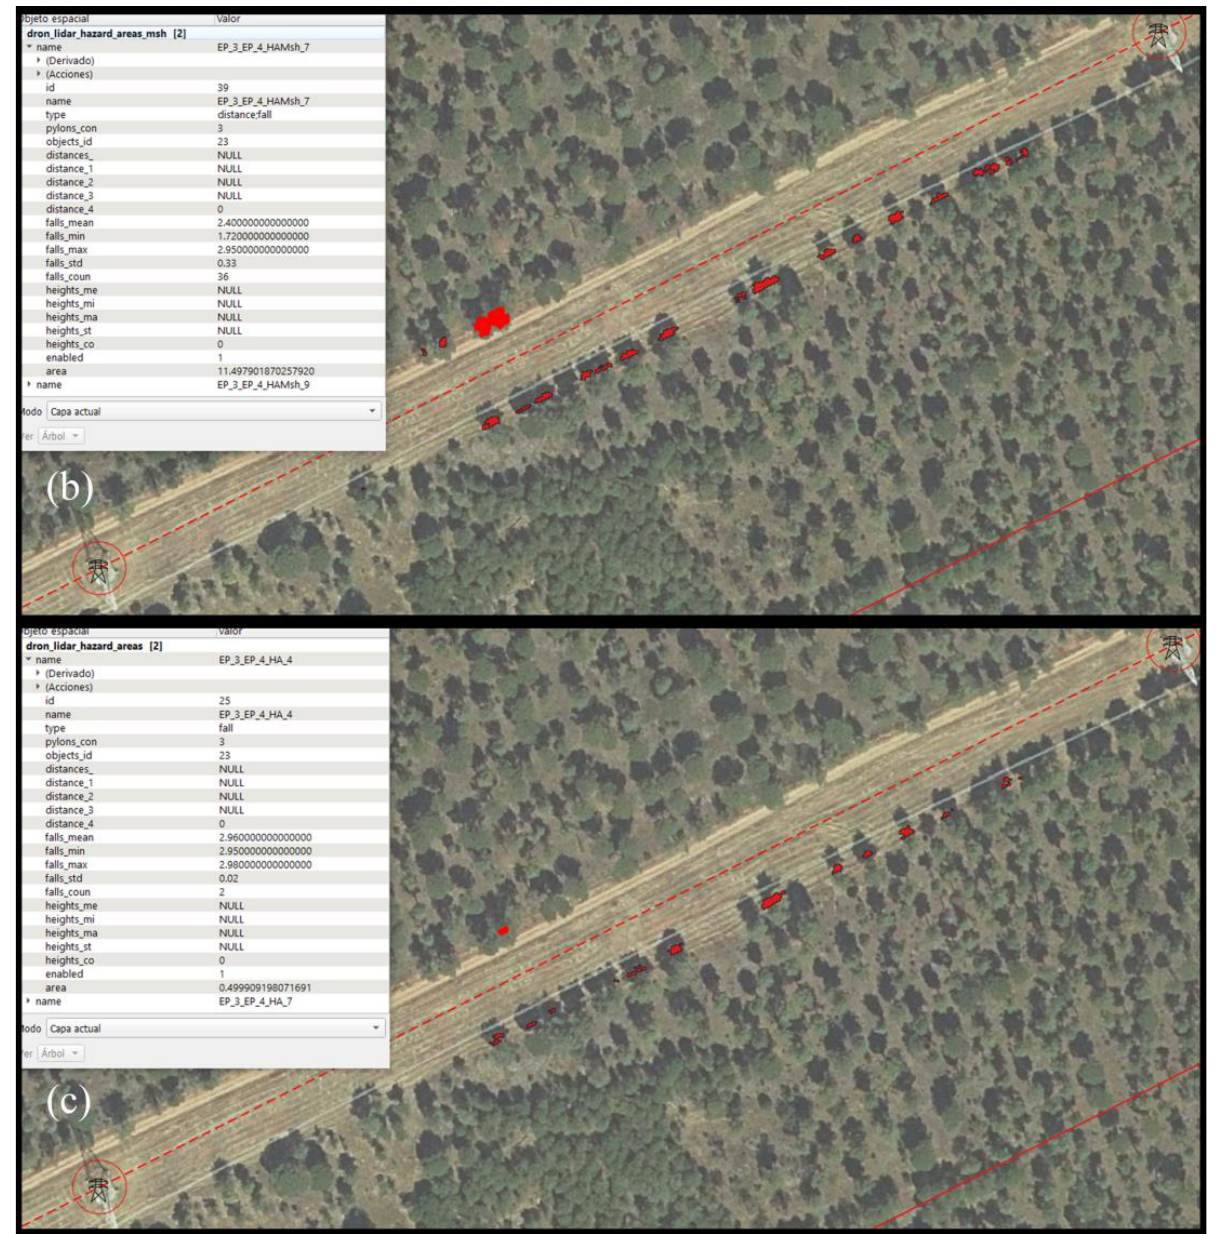
Figure 11. Comparison of risk areas obtained for the three processing types: ( a ) Public airborne LiDAR data with theoretical catenary; ( b ) drone LiDAR data with theoretical catenary; and ( c ) drone LiDAR data with real catenary.